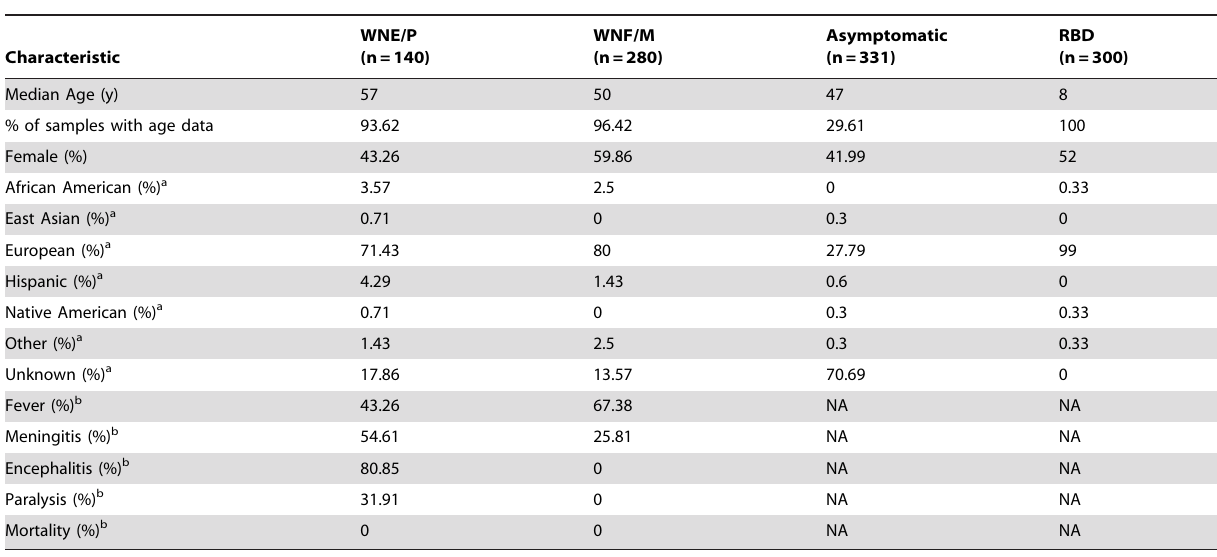
Table 1. Subject